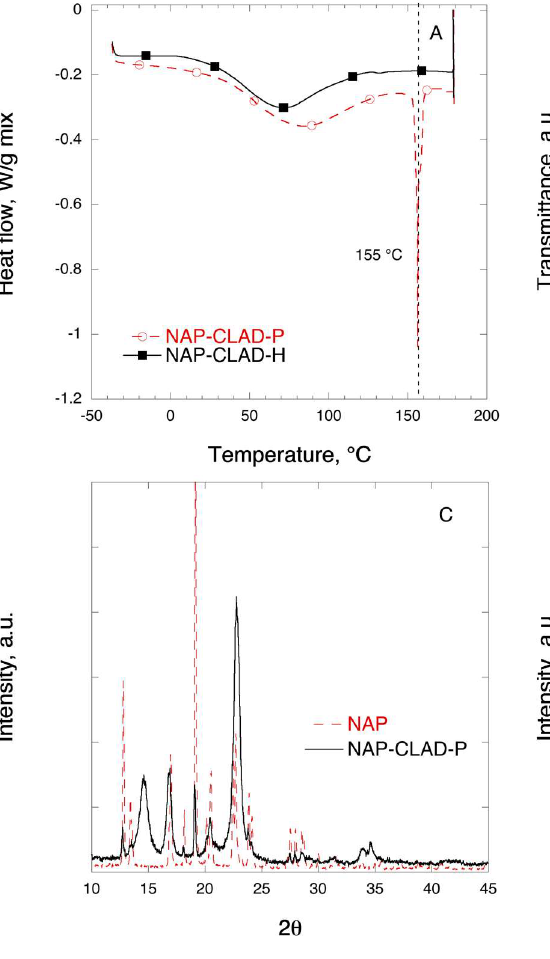
Figure 10. Solid-state analysis of NAP-CLAD 10% w / w mixtures: ( A ) DSC, ( B ) FTIR, ( C ) XRD for P-mixture, and ( D ) XRD for H-mixture. The symbols are only a guide for the eye.